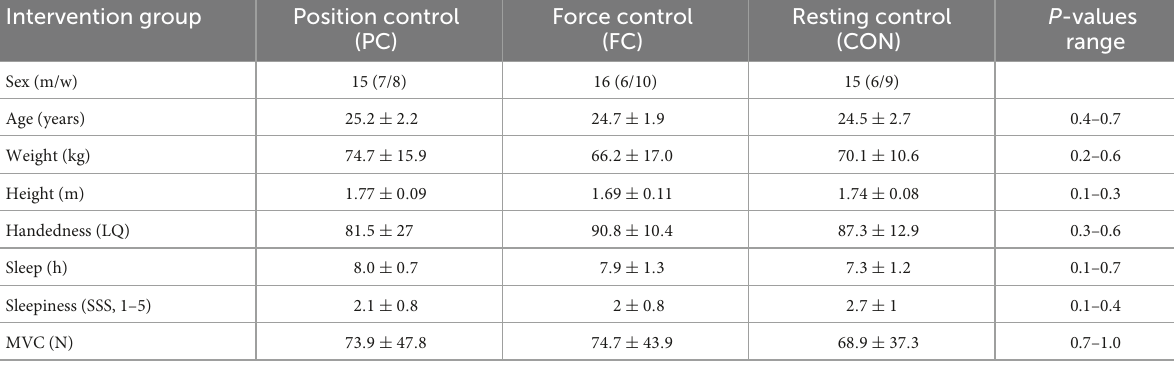
TABLE 1 Main experiment: Characteristics of participants.